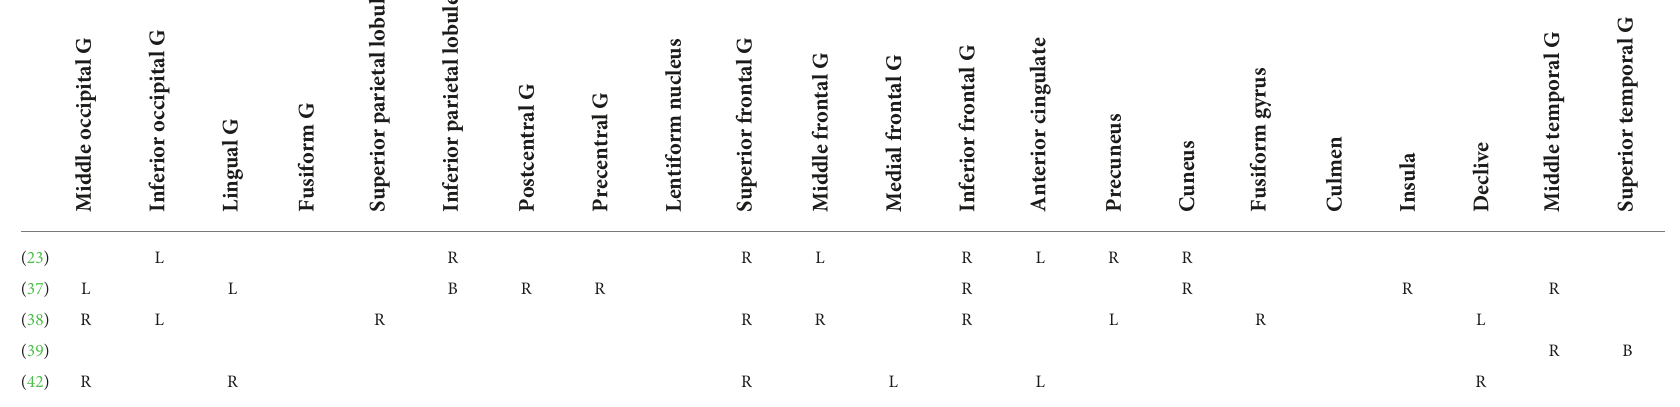
TABLE 4 Qualitative label-based meta-analysis of the five studies concerning food